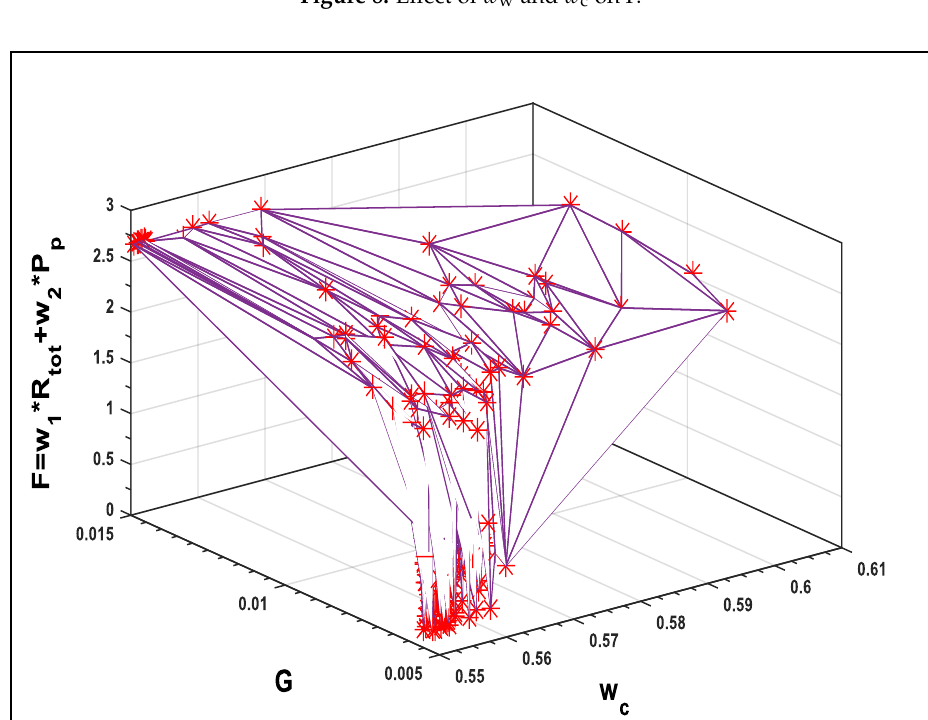
w on F. w on F. c c